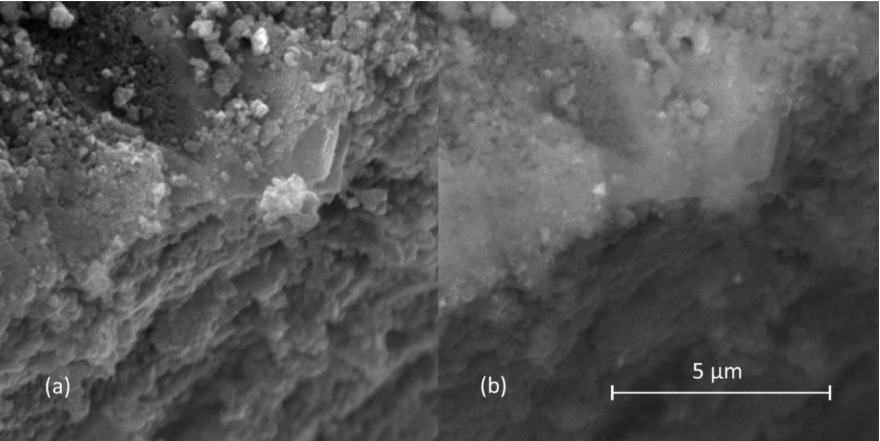
Figure 1. SEM micrographs of prepared photocatalyst in ( a ) secondary electron and ( b ) backscattered electron